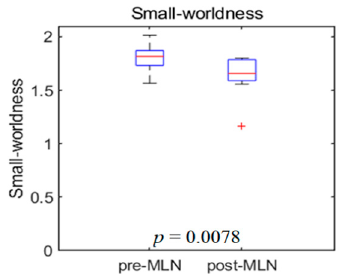
Figure 6. Boxplot illustrates the distribution change of the small-world as the functional connectivity of neural networks in fibromyalgia patients’ brains due to MLN drug therapy. Left: before medication, right: after medication.